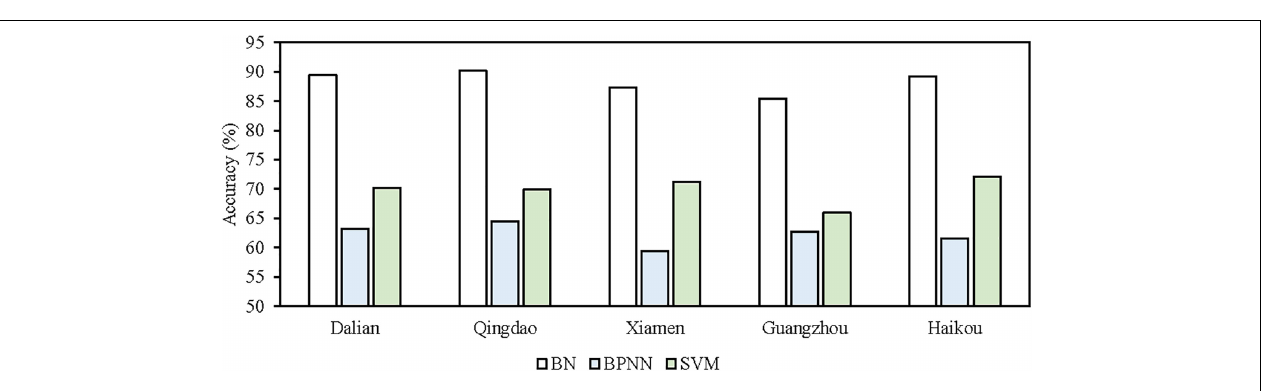
FIGURE 8 | Risk assessment of different coastal